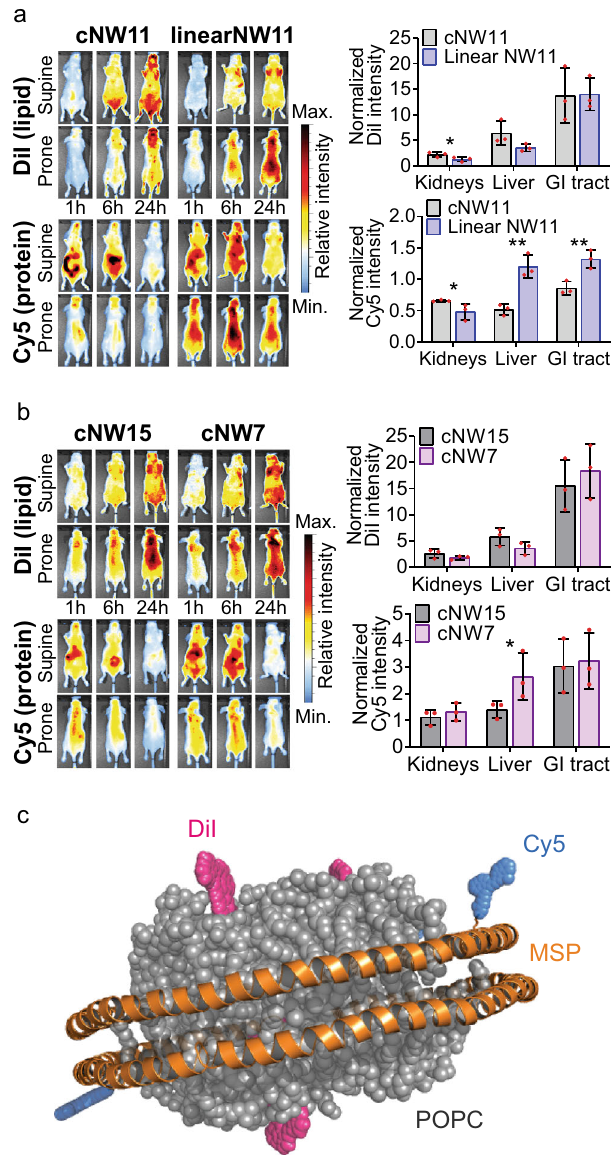
Fig. 5 In vivo biodistribution of nanodiscs in naïve BALB/c nude mice. Animals were administered fl uorescent nanodiscs via the tail vein and imaged 1, 6, and 24 h post injection. Imaging of the Cy5 conjugated MSP protein was performed using 620 nm excitation and 670 nm emission fi lters and the lipophilic DiI dye (loaded into the bilayer) using 540 nm excitation and 620 nm emission fi lters. a Comparison of cNW11 and linear NW11 distributions. DiI intensity, localised to regions of fat deposits, increases with time reaching a peak at 24 h post injection for both linear and cyclised nanodiscs. Cy5 distribution demonstrates clearance of both linear and cyclic nanodiscs through the GI tract at early time points. Ex vivo analysis of clearance organs demonstrates higher linear NW11 protein in the liver 24 h post injection compared to cNW11 but lower DiI suggesting increased metabolism. Ex vivo organ fl uorescence data is presented as mean normalised radiant ef fi ciency values ( n = 3) with standard deviation error bars. b Comparison of cNW15 and cNW7 distributions. Both cNW15 and cNW7 demonstrate similar distributions to cNW11. Ex vivo analysis demonstrates higher cNW7 protein in the liver compared to cNW15, similar was performed using unpaired two-tailed t-tests, * p -value ≤ 0.05,